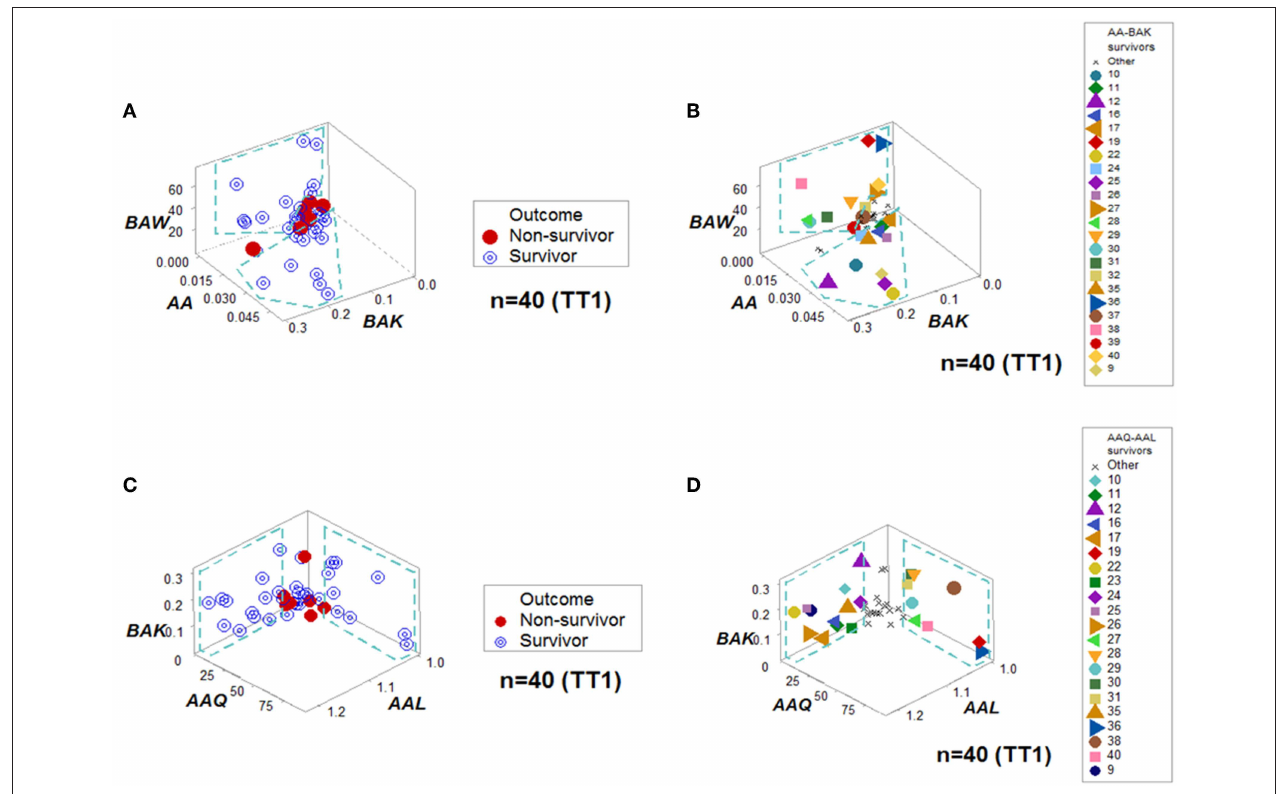
FIGURE 4 | Personalized prediction for survival at admission. Two data structures clustered, at the first temporal test (TT1), 75% (24/32) of all survivors within data ranges that did not include non-survivors. (A,B) denote the patterns and patient identifiers of the first data structure, while (C,D) display those of the second data structure. Twenty of the twenty-four survivors (83.3%) were redundantly